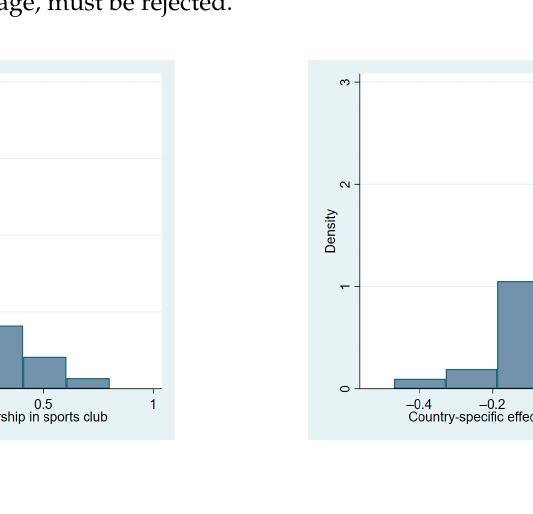
Figure 6. Estimated country ‐ specific effects for active membership in sports clubs ( a ) and inactive membership in sports clubs ( b ) for the group of women. Source: WVS ‐ EVS data.